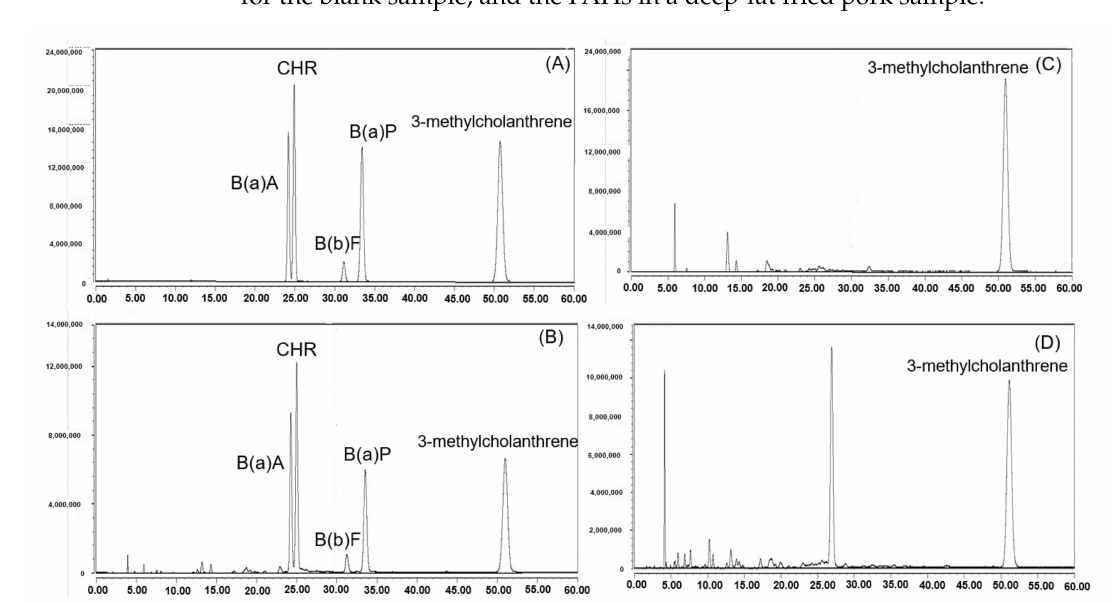
Figure 1. HPLC-FLD chromatograms of four PAHs standards ( A ); four PAHs with spiked sample ( B ); internal standards with blank sample ( C ); and chromatograms of PAHs for sample ( D